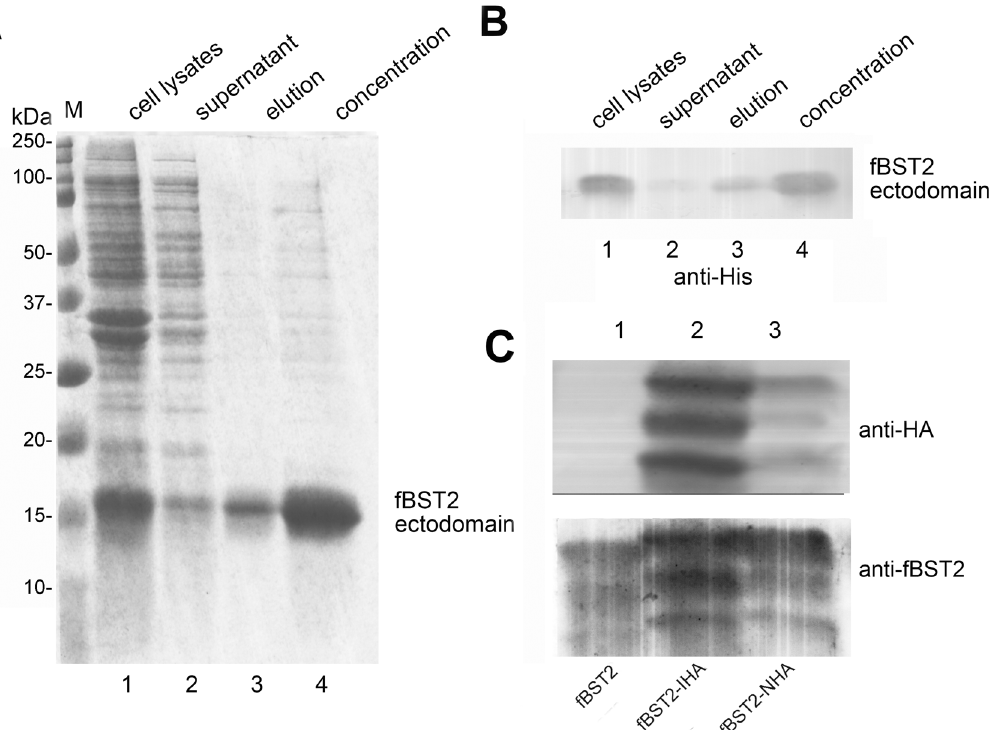
Fig 2. Purification of BST2 ectodomain and validation of antibody. (A and B) Purification of fBST2 ectodomain (15 kDa). The protein was purified by affinity chromatography from 6 L of E . coli BL21 transformed with fBST2 ectodomain expression plasmids based on the pET-26b (+) vector. Samples collected from the purification procedures were analyzed by SDS-PAGE with Coomassie Brilliant Blue staining (A) and Western blot (B) using an anti-His antibody. (C) Validation of pAb against fBST2. 293T cells were transfected with 500 ng of fBST2, fBST2-IHA and fBST2-NHA. After 48 h, cells were analyzed by Western blotting using the anti-fBST2 pAb and anti-HA